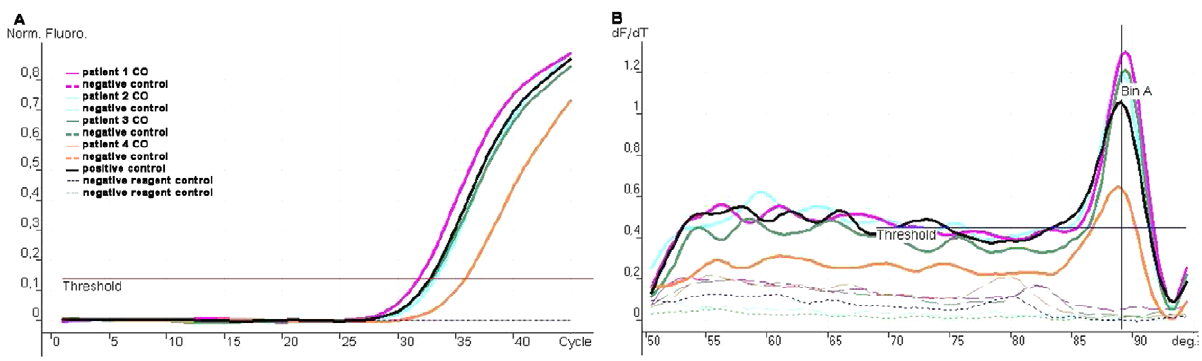
Figure 3. Amplification of T. cruzi DNA extracted from blood of four patients with HIV/T. cruzi coinfection (CO). Colored continuous lines represent CO patients (4.83–142.4 parasites/mL), and black line represents the positive control, 5 6 10 2 14 parasites/mL. A) Dashed lines represent the controls without Chagas disease, and the negative controls for the reagents and room of DNA application. B) Dashed lines represent the negative control individual without Chagas disease for each patient. Dotted lines represent the negative controls for the reagents and DNA